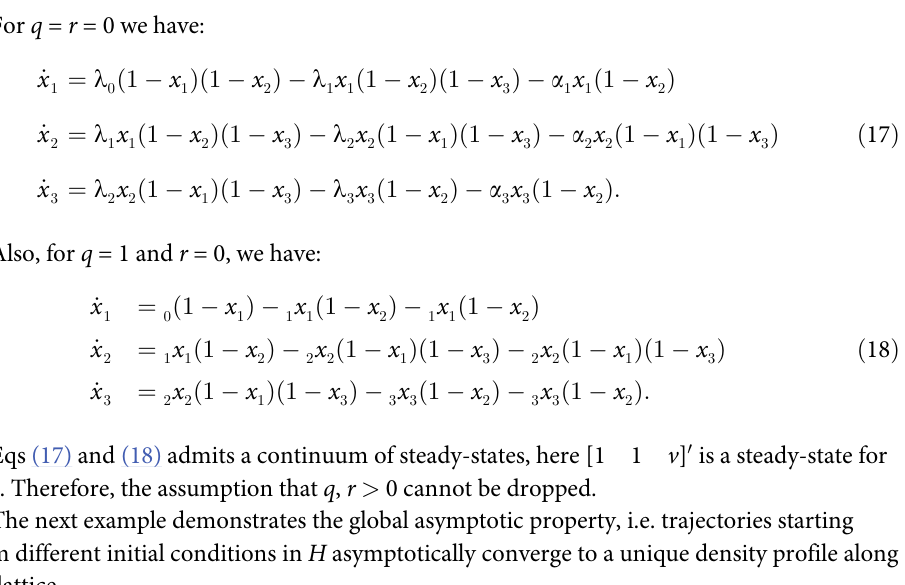
PLOS ONE | https://doi.org/10.1371/journal.pone.0267858 May 2,